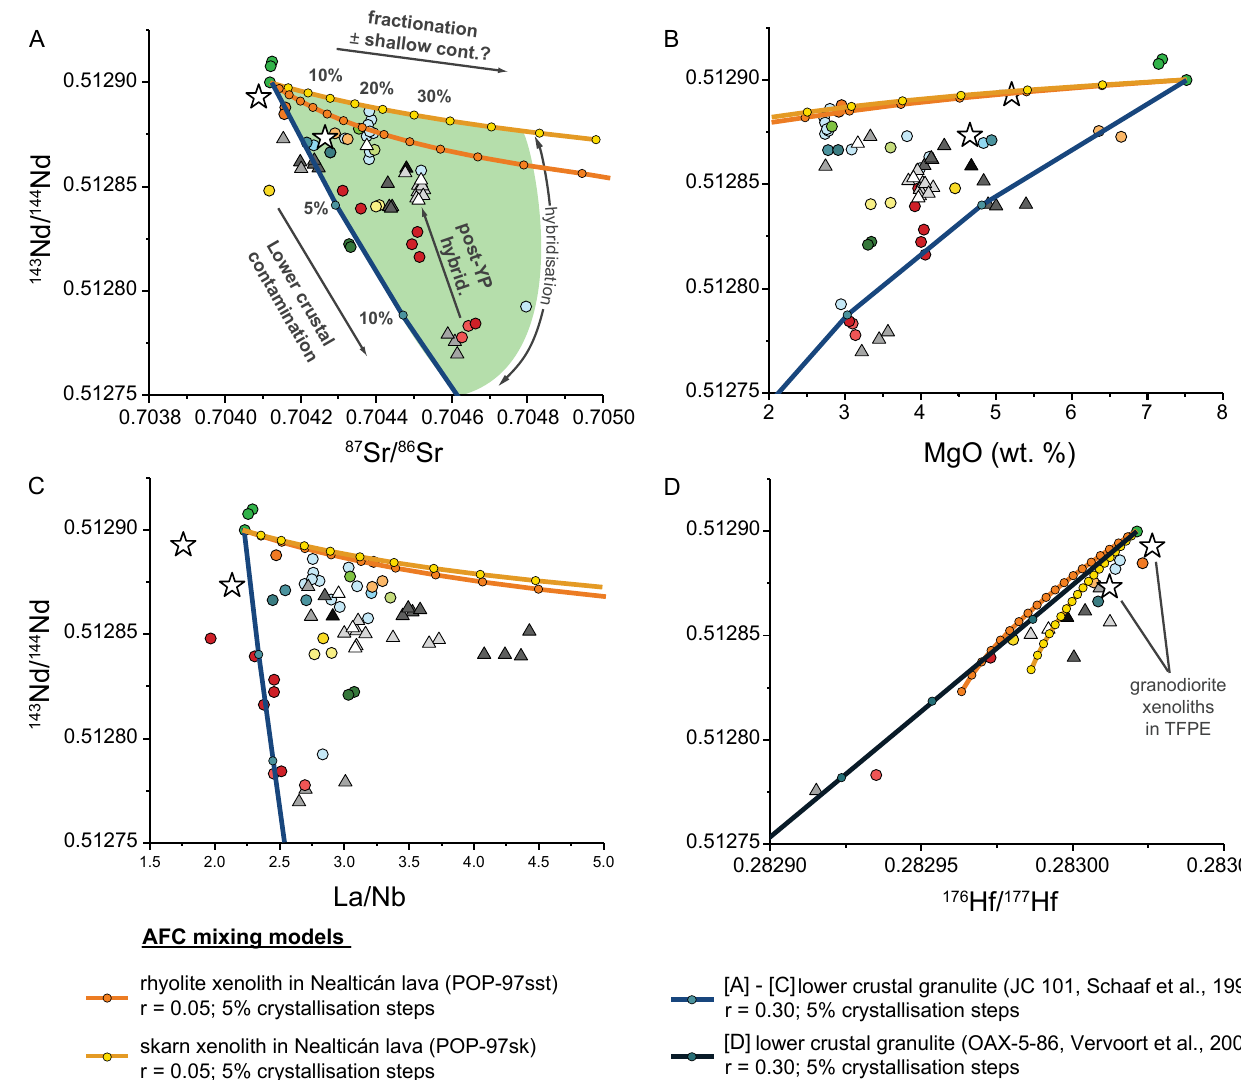
rhyolite xenolith in Nealticán lava (POP-97sst) r = 0.05; 5% crystallisation steps skarn xenolith in Nealticán lava (POP-97sk) r = 0.05; 5% crystallisation steps Figure 11: AFC models calculated for mixing of crustal components with the least evolved unit of the sample suite, Chipiquixtle. Four panels show 143 Nd/ 144 Nd vs [A] 87 Sr/ 86 Sr; [B] MgO; [C] La/Nb; [D] 176 Hf/ 177 Hf. See text for